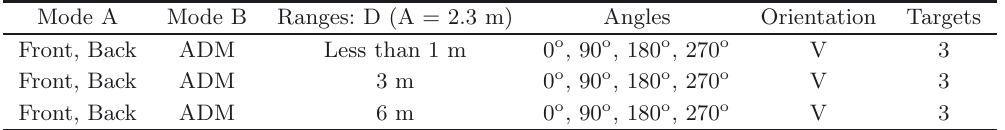
Table 2. Two face test configurations.